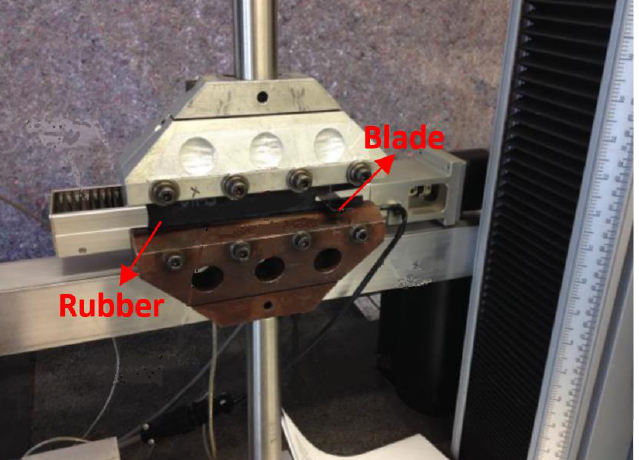
Figure 3. The setup of the rubber cutting experiment.